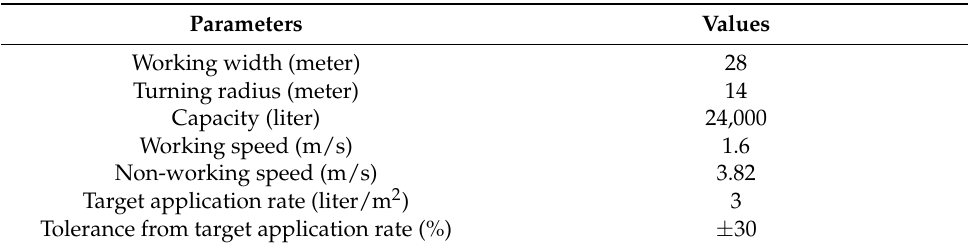
Table 1. Input parameters to the model for sample field 1.